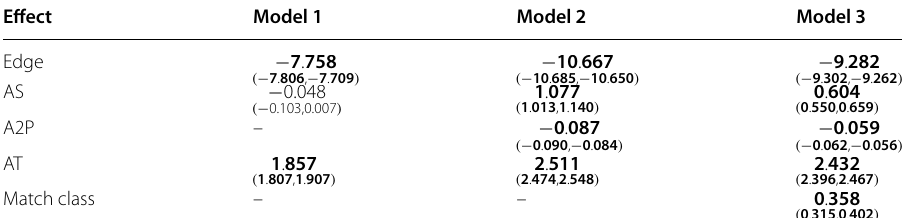
Parameter estimates that are statistically significant are shown in bold